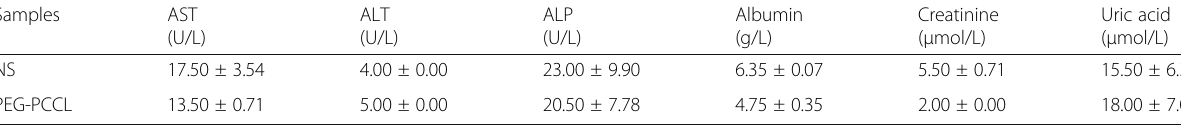
Table 2 The hepatorenal function of mice treated with PEG-PCCL (mean ± SD, n = 2) Samples